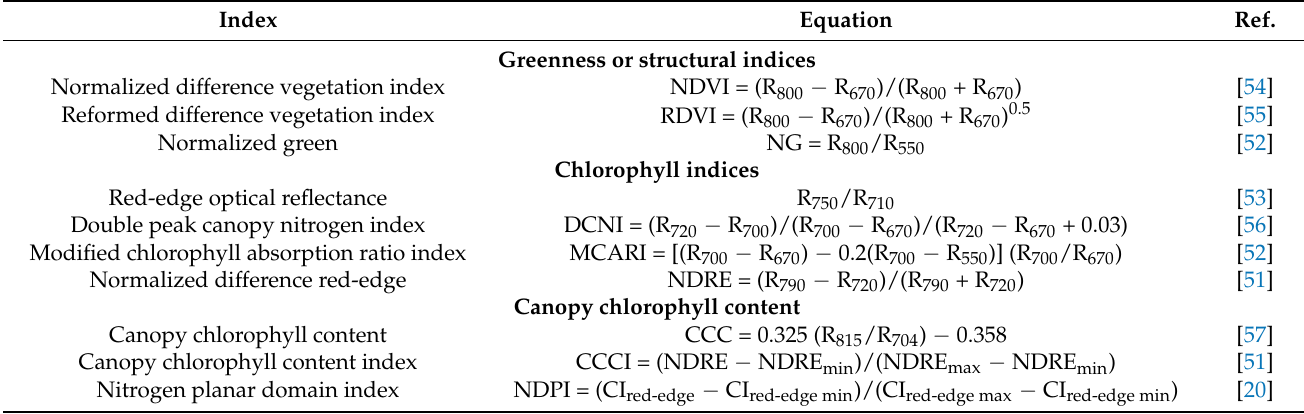
Table 1. Selected airborne hyperspectral indices used in this study and their reference